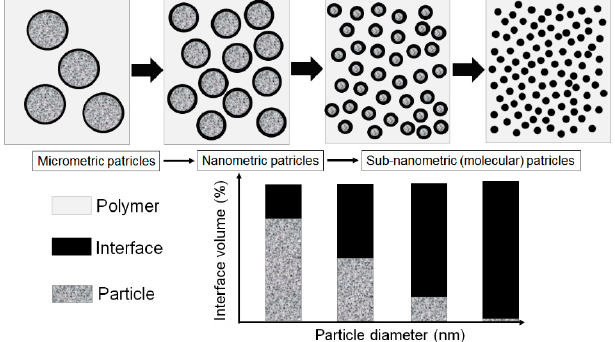
Figure 4. Schematic representation of the ratio particles/interfaces changes with the size of the filler (Redrawn and adapted figure from [30]). (Redrawn and adapted figure from